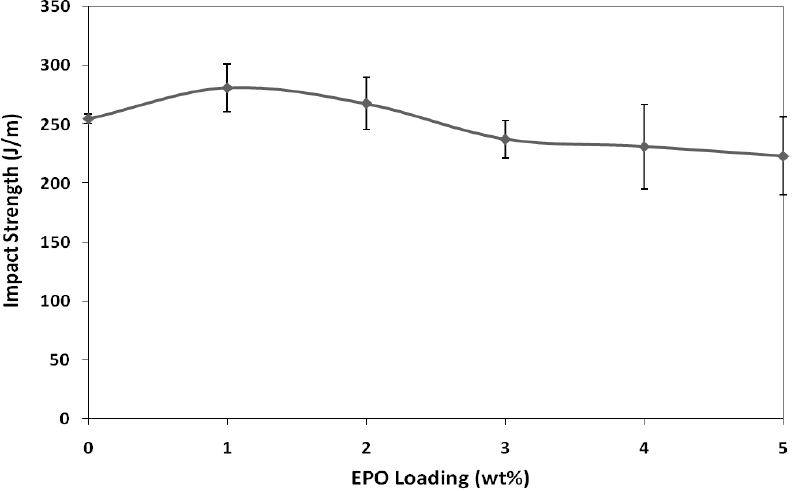
Figure 4. Impact strength of neat PLA and PLA/EPO blends.